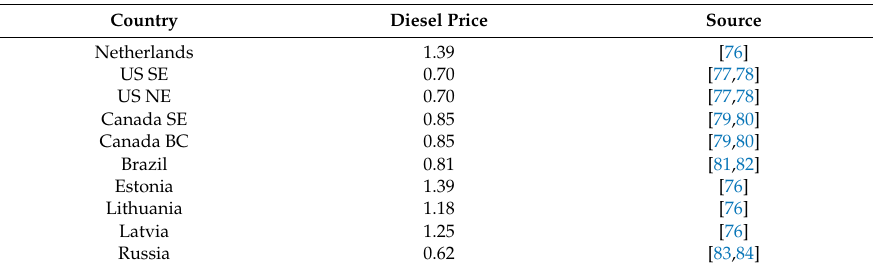
Table A2. Diesel costs used in this study, in € / L.